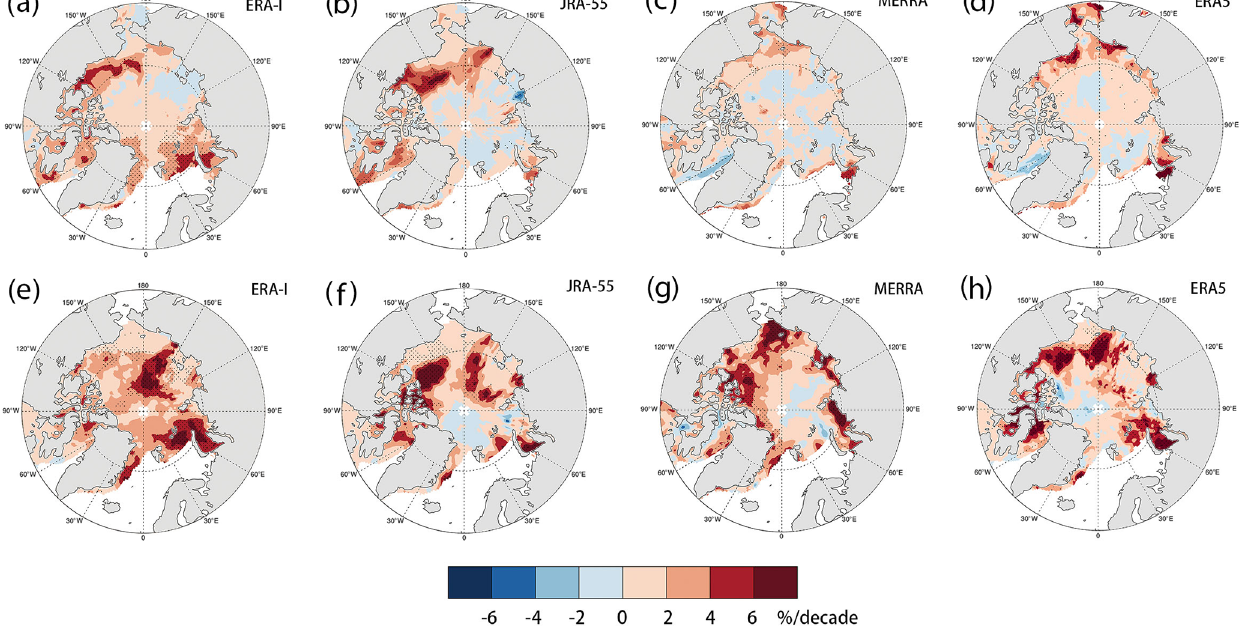
Figure 5. Linear trend of rainfall–precipitation ratio (RPR) in May (upper panel) and June (bottom panel) over Arctic sea ice during 1980– 2017 in ERA-I (a, e) , JRA-55 (b, f) , MERRA (c, g) , and ERA5 (d, h) . Regions passing the 0.05 significance test are denoted by black